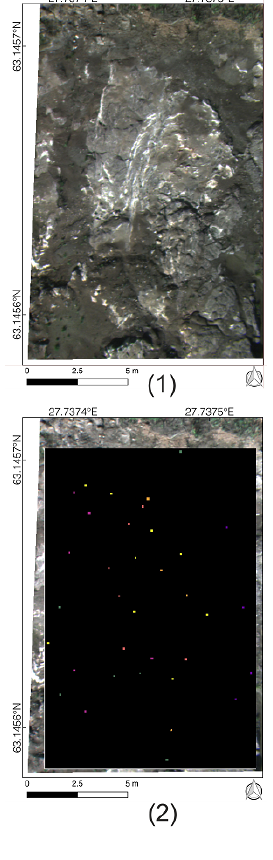
Figure 2. (1) RGB image, and (2) ground truth data points of the Figure 3. (1) RGB image, (2) ground truth data points of the